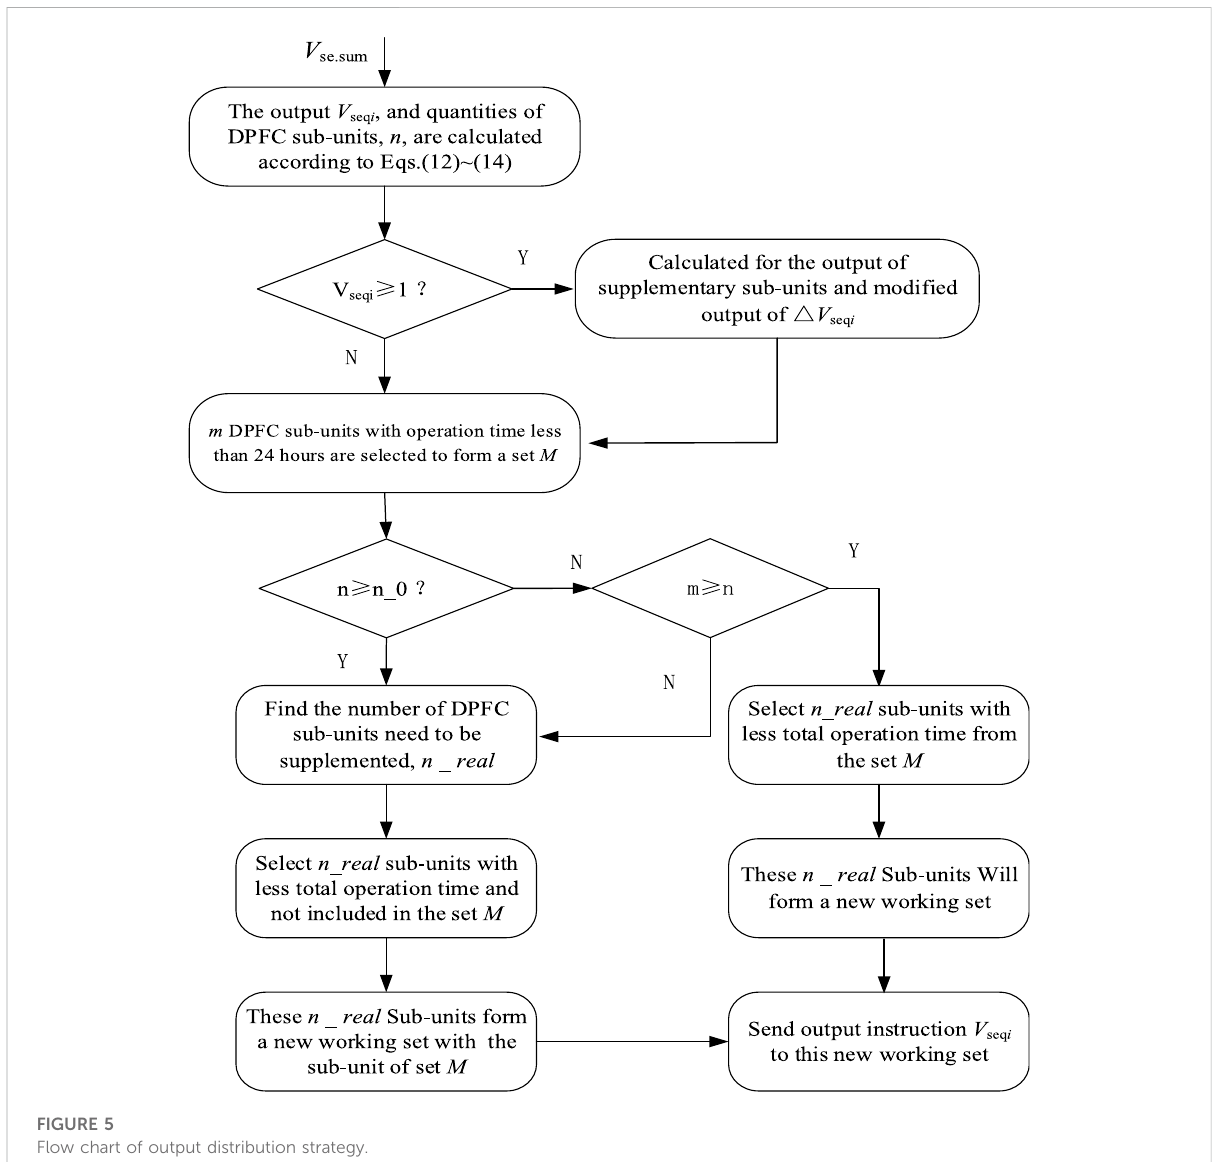
FIGURE 5 Flow chart of output distribution